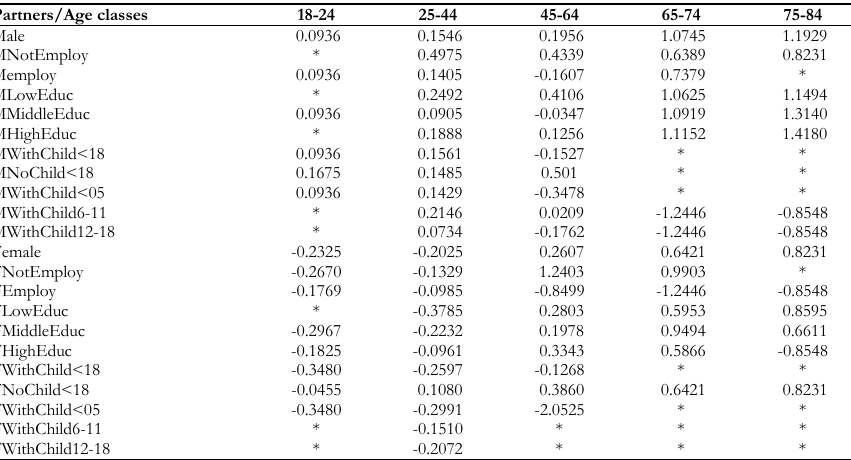
Note: * = the phenomenon does not